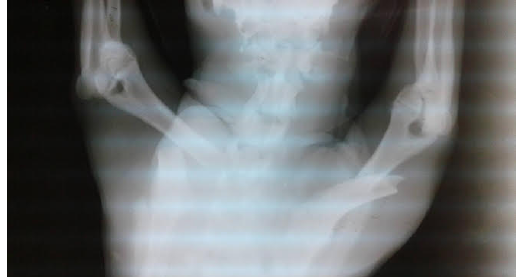
Fig. 8. Radiography in young dog showed transverse fracture of both humerus